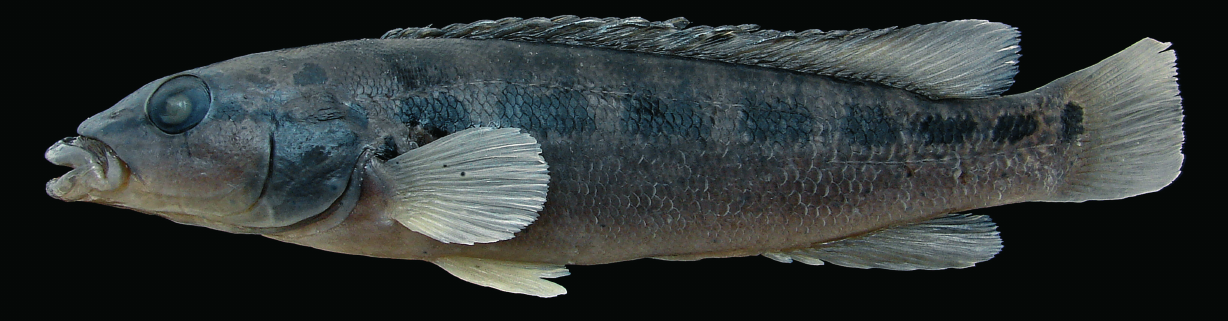
Fig. 7 . Crenicichla empheres , paratype, rio Chapecó, Abelardo Luz, Santa Catarina, MCP 40176 (124.3 mm SL,